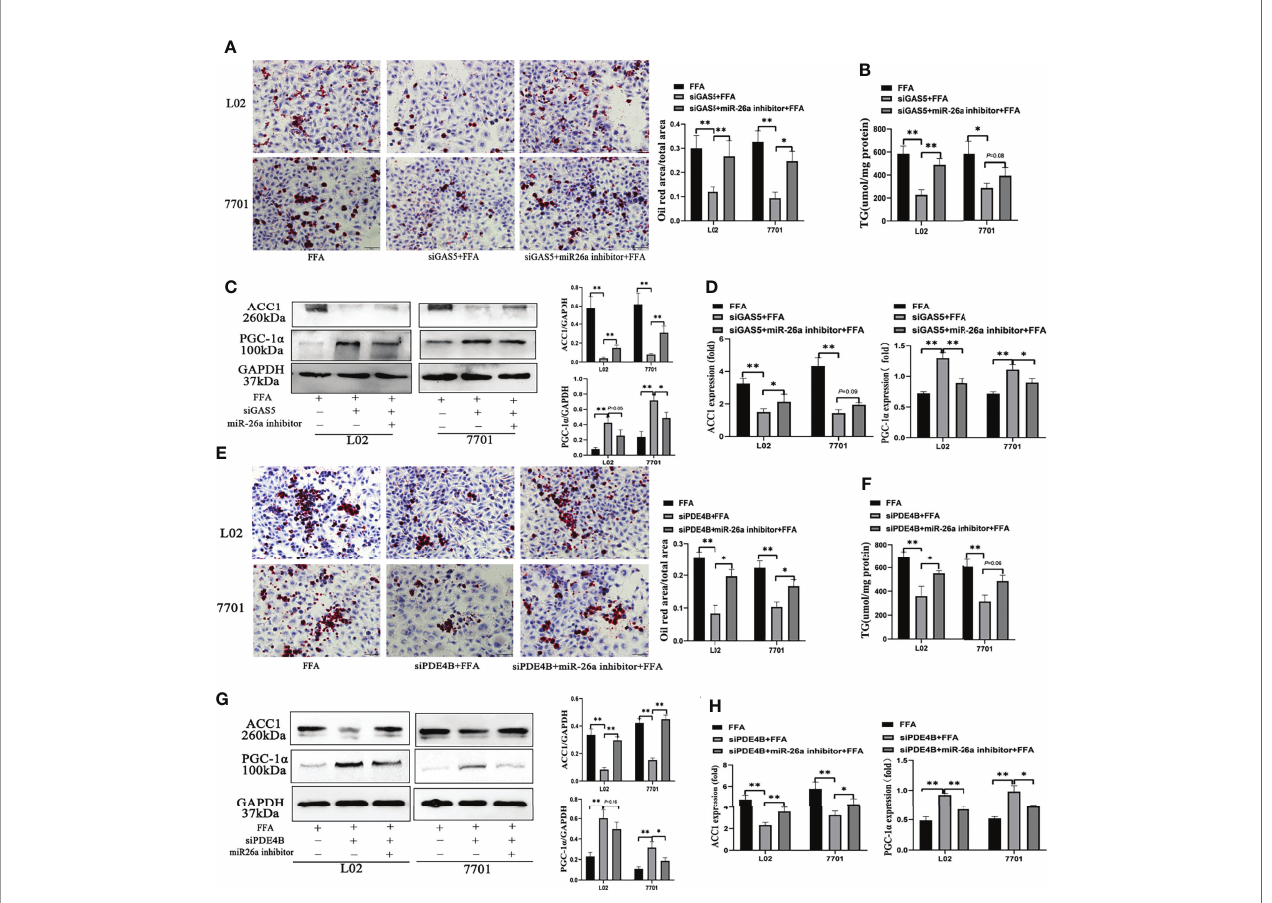
FIGURE 6 | The regulation of the long non-coding RNA growth arrest speci fi c 5 (GAS5)/miR-26a-5p/phosphodiesterase-4D (PDE4B) axis in lipid metabolism. Cells were transfected with small interfering (si)GAS5 or siGAS5 plus miR-26a-5p inhibitor and stained with oil red (Original magni fi cation, ×200) (A) . Triglyceride (TG) levels were detected using a commercial kit (B) , and the protein and mRNA expression of ACC1 and PGC-1 a was detected via western blot and quantitative real-time polymerase chain reaction analysis (RT-qPCR), respectively (C, D) . Cells were stained with oil red after transfection with siPDE4B or siPDE4B plus a miR-26a-5p inhibitor, (Original magni fi cation, ×400) (E) , TG levels detection (F) , and the protein and mRNA expression of ACC1 and PGC-1 a was detected via western blot and RT-qPCR, respectively (G, H) . Data are expressed as mean ± standard error of mean. * P < 0.05 and ** P < 0.01, n =